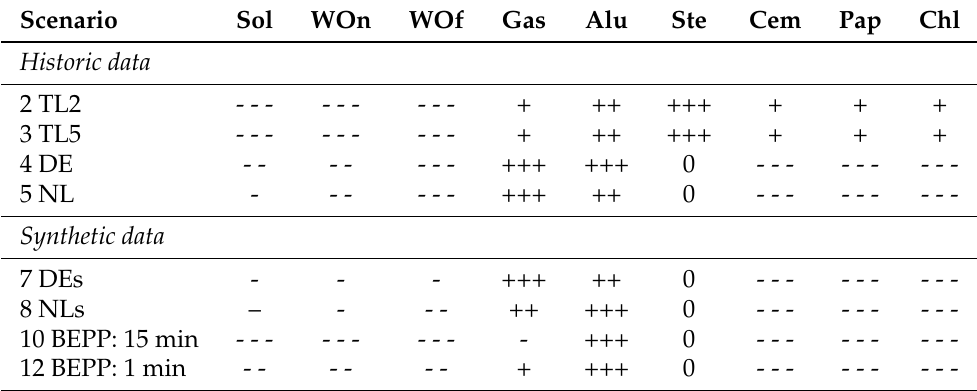
Table 12. Overview of the technologies’ energy balance in the investigated scenarios.